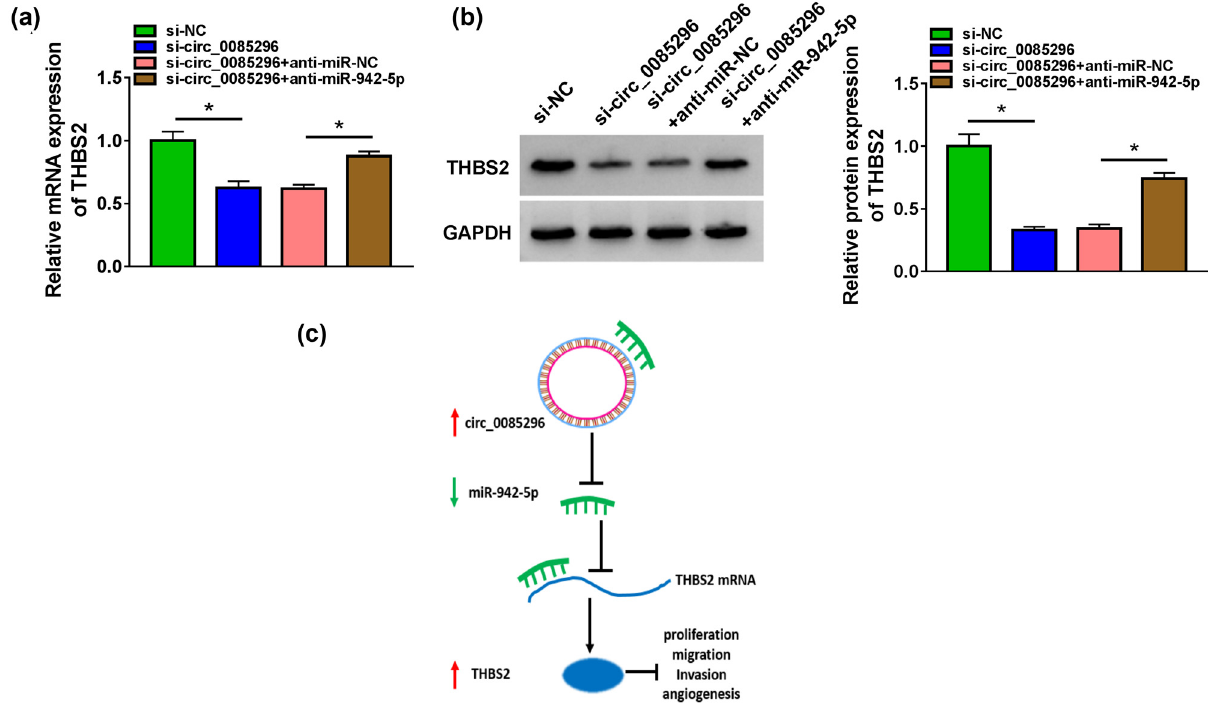
Figure 7: circ_0085296 positively regulated THBS2 via sponging miR - 942 - 5p. ( a and b ) The mRNA and protein expression of THBS2 was measured by qRT - PCR and WB analysis in HTR - 8/SVneo cells co - transfected with si - circ_0085296 and anti - miR - 942 - 5p. ( c ) The main idea diagram of this study. * P <